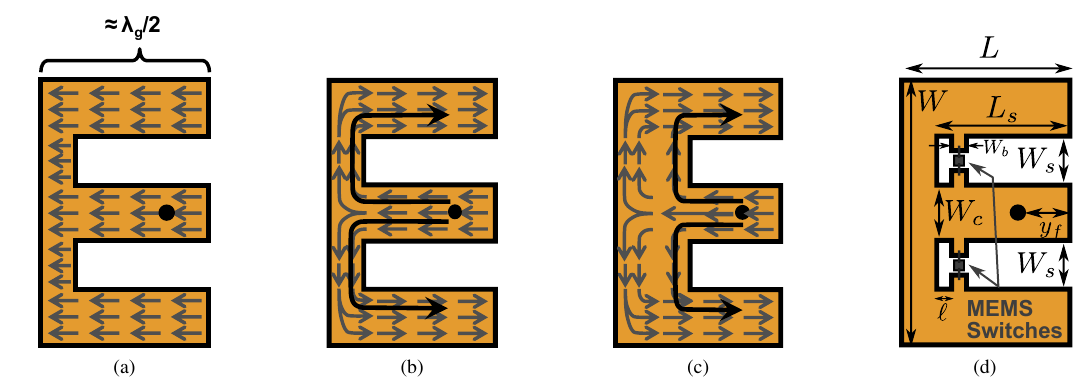
FIGURE 18. (a) Radiating patch mode currents. (b) Non-radiating slot mode currents. (c) Changing the slot dimensions to change the resonant length of the E-shaped patch antenna. (d) Frequency reconfigurable E-shaped design with MEMS switches. Adapted from [26].